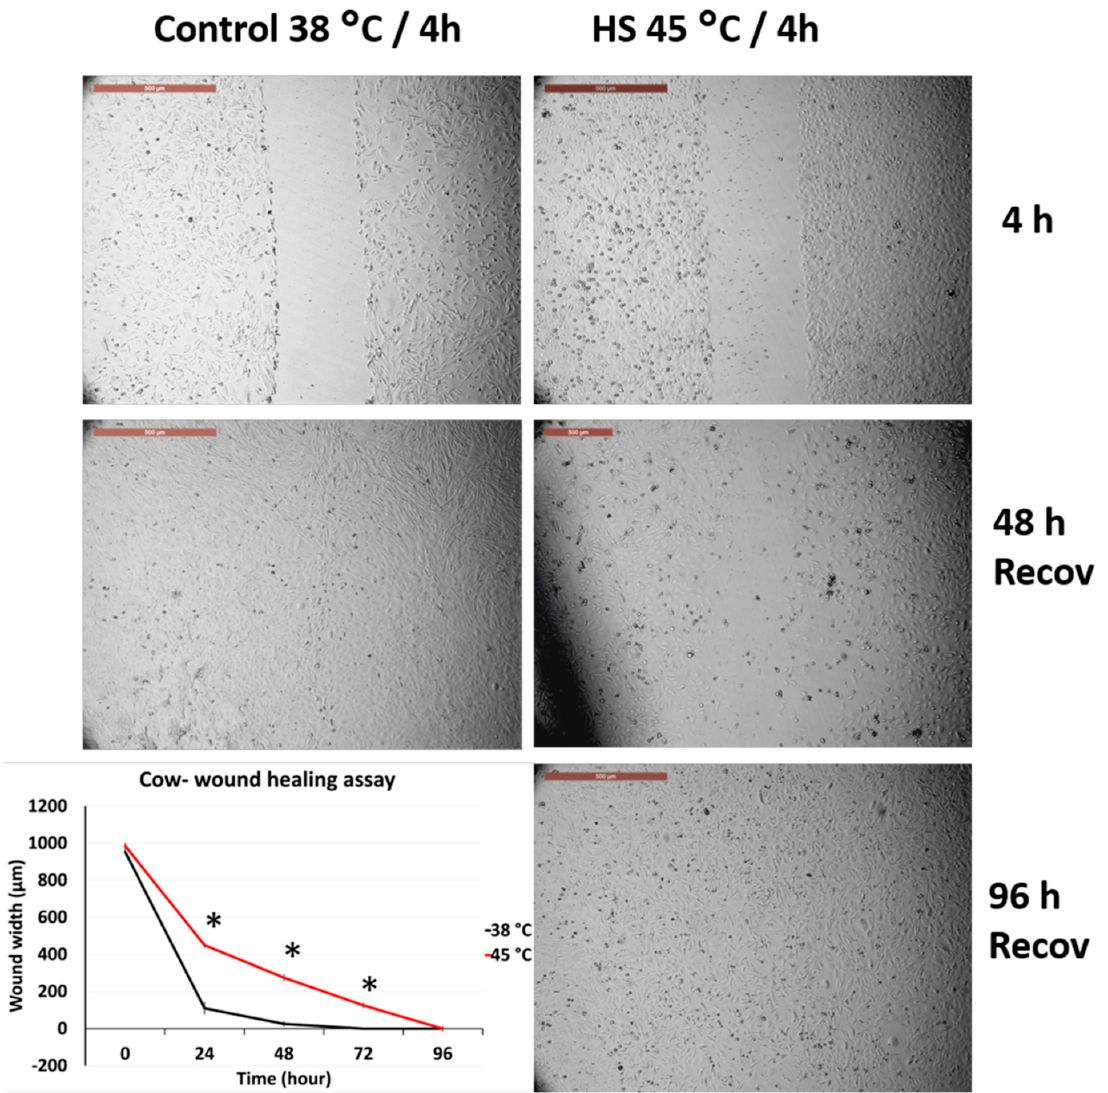
Figure 2. Wound healing (cell scratch) assay for cow primary cultured fibroblasts exposed to 45 °C for 4 h and control cells (38 °C for 4 h). Cells were incubated under the required conditions, recovered at 38 °C, and monitored daily for wound closure. Scale bar = 500 µm. Data are presented as means ± SEM, values of the same timings were analyzed using Student’s t -test, and asterisks (*) indicate significant differences at p < 0.05.